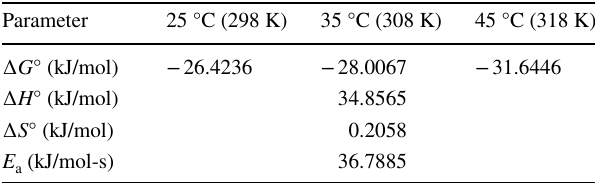
Table 7 Thermodynamic parameters at varying